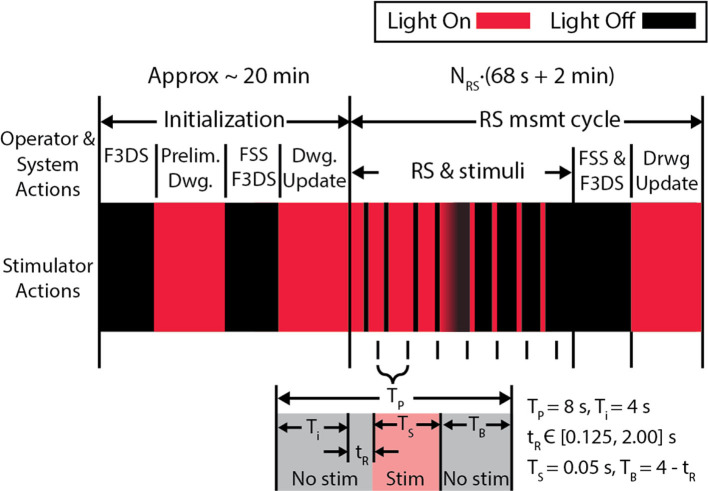
The experiment protocol used to validate the microscope. An initial stimulus, consisting of alternating screens “ON” and “OFF” are displayed during the initial F3DS, after which the user draws the initial morphology in the CTAK UI. The RS executes immediately after the initial drawing of the neuron structure, and stimuli are displayed while recording the 3D, evoked activity in the dendritic arbor AP firing. In this stimulation routine, 9 stimuli are presented in sequence-−4 OFF pulses on a bright background a transition shift from the bright background to the dark background and 4 ON pulses on a dark background. Each stimulus is displayed within an 8 s interval (TP) and has a buffer time, TB, before and after the stimulus.